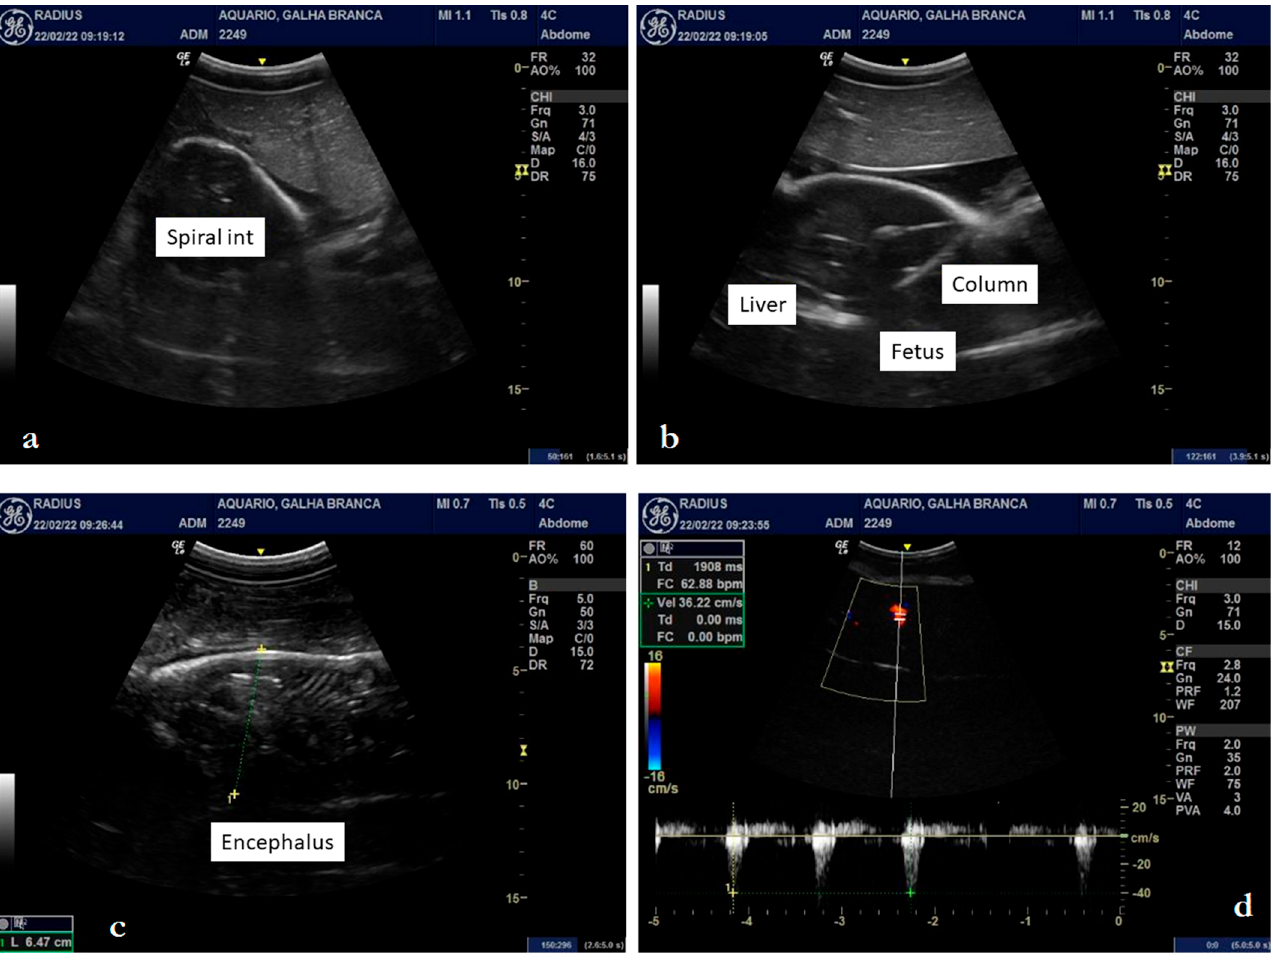
Figure 3. Ultrasonography of a female Triaenodon obesus (Rüppell, 1837) in late pregnancy: intestinal spiral and parietal stratification ( a ), cartilaginous skeleton, forming a posterior acoustic shadow artifact ( b ), biparietal diameter of 6.47 cm ( c ), and cardiac blood flow of 62 beats per minute ( d ).